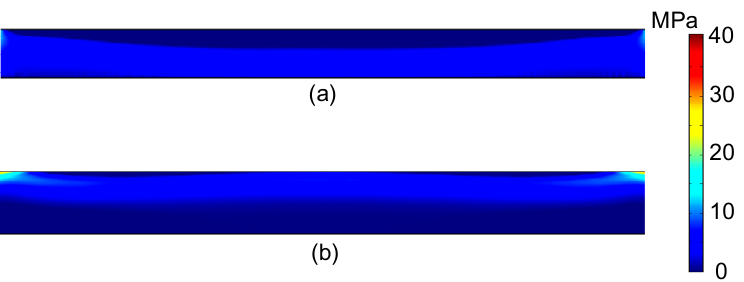
Figure 9. Pressure distributions along contact interface of ( a ) initial and ( b ) optimized CMI.